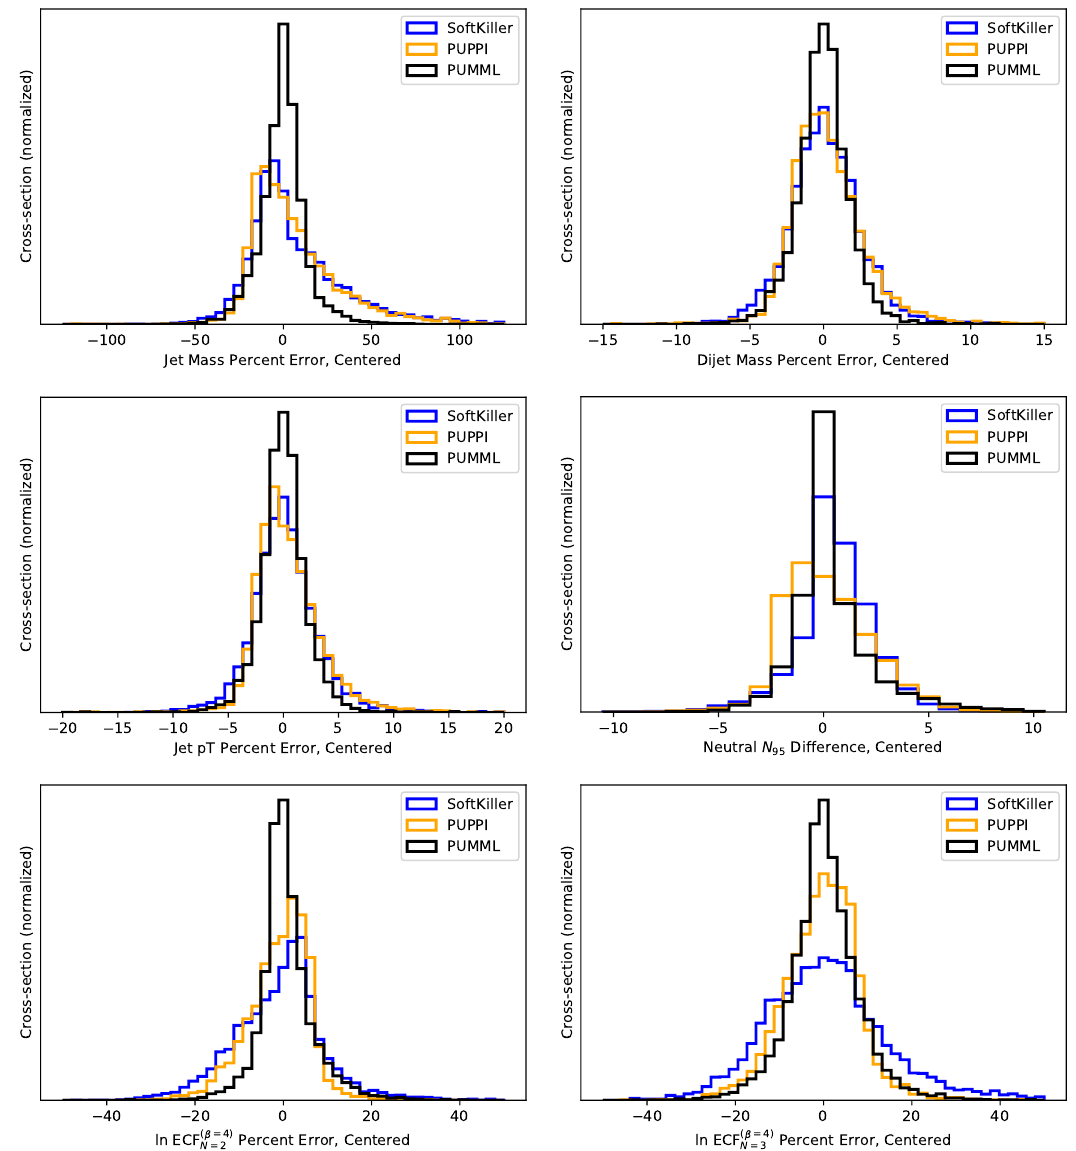
Figure 5 . Distributions of the percent error between reconstructed and true values for leading jet mass (top left), dijet mass (top right), leading jet p T (middle left), neutral N 95 (middle right), ln ECF ( (cid:12) =4) (bottom left), and ln ECF ( (cid:12) =4) (bottom right) for the considered pileup subtraction N =2 N =3 methods with Poissonian h NPU i = 140 pileup. For the discrete neutral N 95 observable, only the di(cid:11)erence is shown. All distributions are centered to have median at 0. The improved reconstruction performance of PUMML is highlighted by its taller and narrower